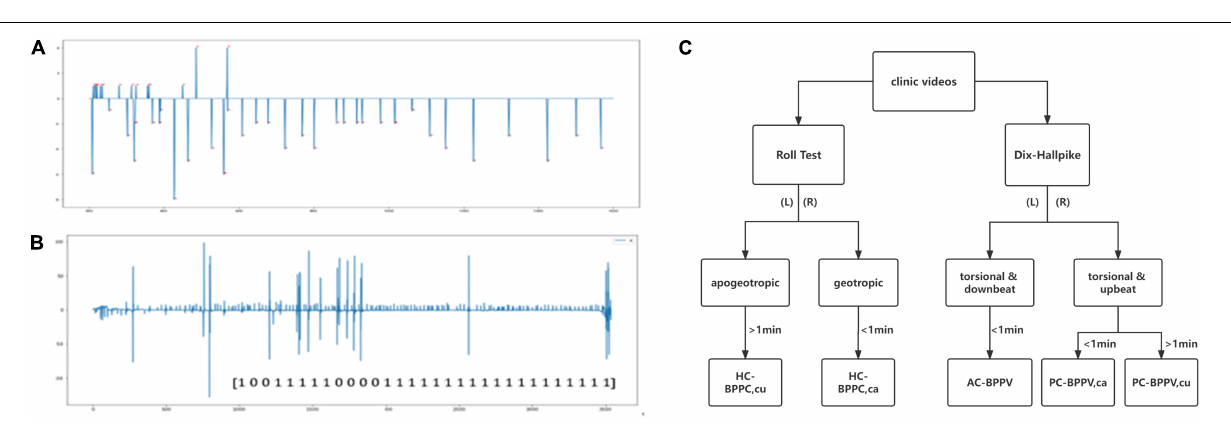
Among the 854 patients in our dataset, 304 (35.6%) were randomly selected as the training set, 93 (10.9%) were randomly selected as the validation set, 122 (14.3%) were selected as the testing set for nystagmus model performance evaluation, and